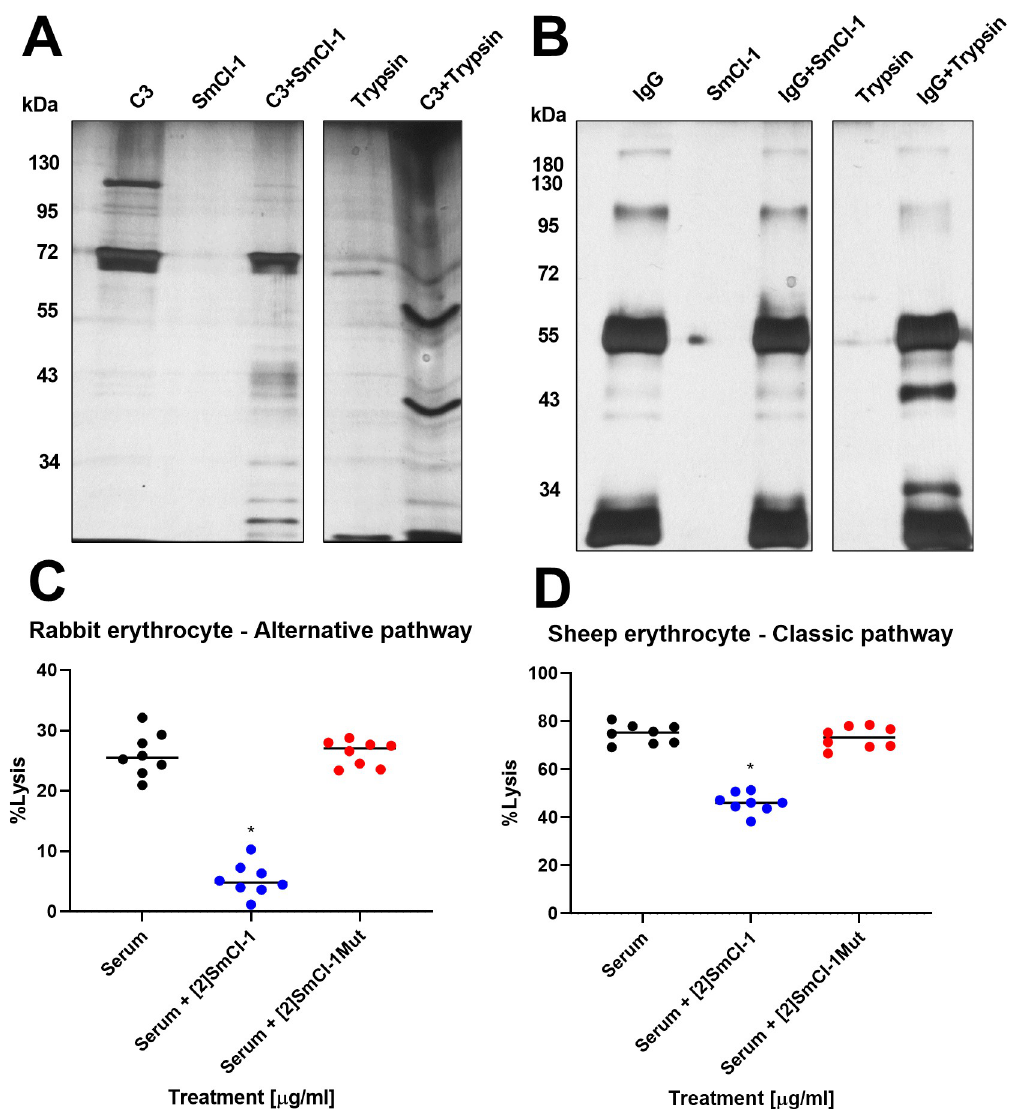
Fig 4. SmCI-1 Cleaves complement component C3. Silver stain of 2 μ g of (A) human complement component C3 loaded into the lanes of a reducing SDS-Page Gel. Under such conditions, C3 is separated into a C3b band at roughly 110kda, and a C3a band of ~72kda. Trypsin treatment resulted in the degradation of both C3b and C3a, while rSmCI-1 degrades only C3b into fragments visible between 26kda and 55kda. (B) Silver stain of human IgG separated into heavy (~50kda), and light (~25kda) chains, with residual complete antibody at higher molecular weights. (C) Rabbit erythrocyte lysis via the alternative complement pathway and (D) Sheep erythrocyte lysis via the classical complement pathway using human serum is decreased by addition of rSmCI-1, but not rSmCI-1Mut. Significant differences from untreated cells indicated by ( � ). (n = 8). lysis from 26.1 ± 1.3% to 5.3 ± 1.0%. A similar observation was made of the classical pathway, which displayed a significant decrease in lysis from 74.8 ± 1.4% to 46.0 ± 1.4% when serum was treated with rSmCI-1. Treatment with rSmCI-1Mut did not result in a significant decrease in lysis, with 26.2 ± 1.6% and 73.2 ± 0.7% lysis seen in the alternative and classical pathway assays, respectively (Fig 4C and 4D). Injection of the SmCI-1 targeting dsRNA construct was successful at reducing the amount of SmCI-1 protein detectable in S . mansoni cercaria. On days 7–10 post injection, isolated